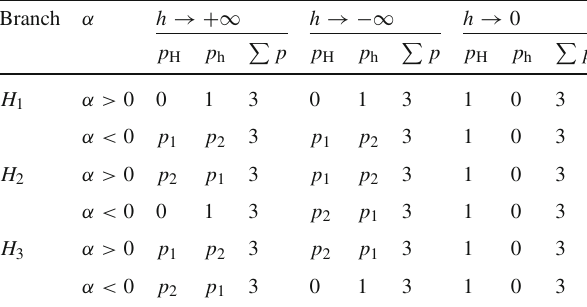
Table 1 Summary of D = 3 power-law (cid:2) -term regimes Branch